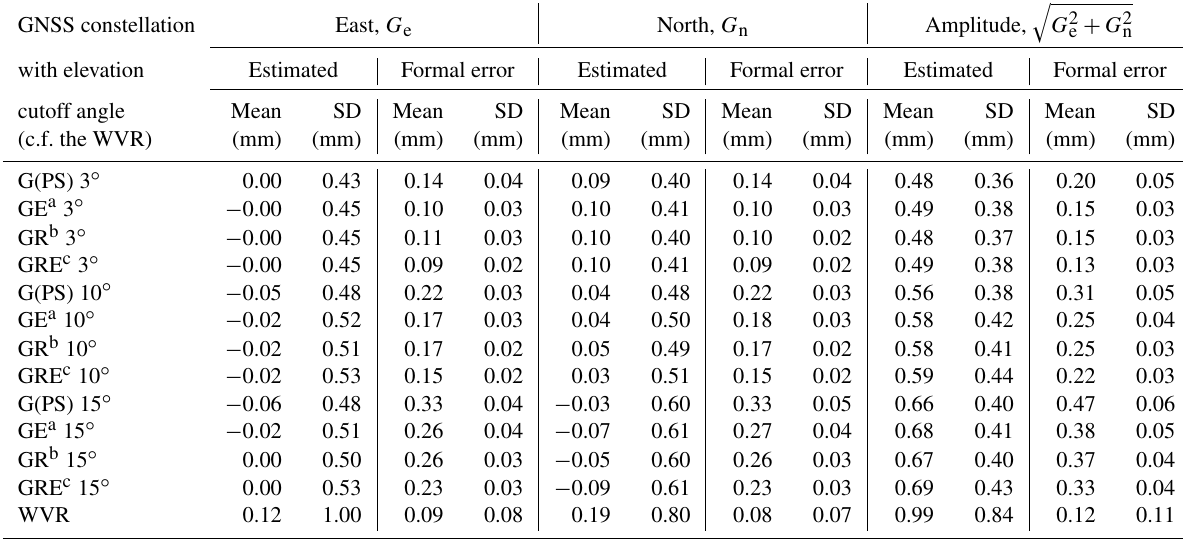
Table 1. The mean and standard deviations (SDs) of the east and the north gradients and the gradient amplitude, together with the mean and SD of their 1 σ formal errors.